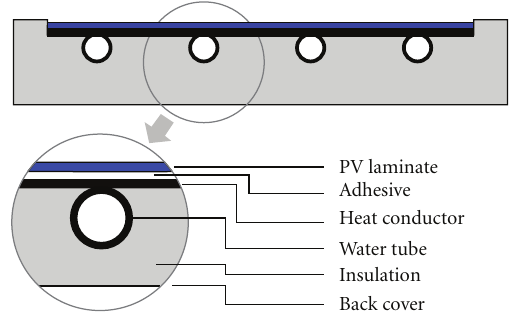
Figure 2: Sectional view of the sheet-and-tube PVT collector.